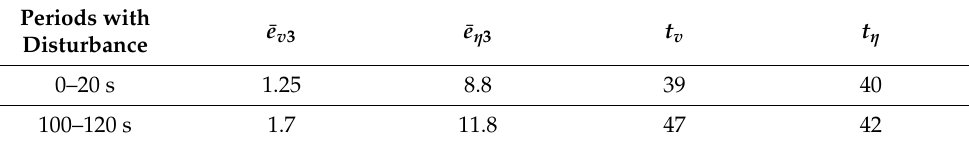
Table 2. Amplitude comparison of errors under different disturbance periods in this paper. (¯ e v 3 and ¯ e η 3 are amplitude of velocity errors position errors in the process of fluctuation; t v and t η are convergence times for velocity and position